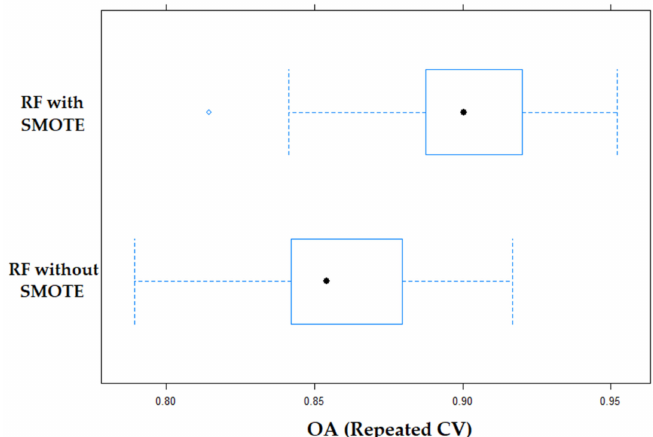
Figure 5. Comparison of OA for the RF model before and after data balancing. The median is shown as black dot in the box, while first and third quartiles define the box. The whiskers define the minimum and maximum of the data while outliers are shown as blue